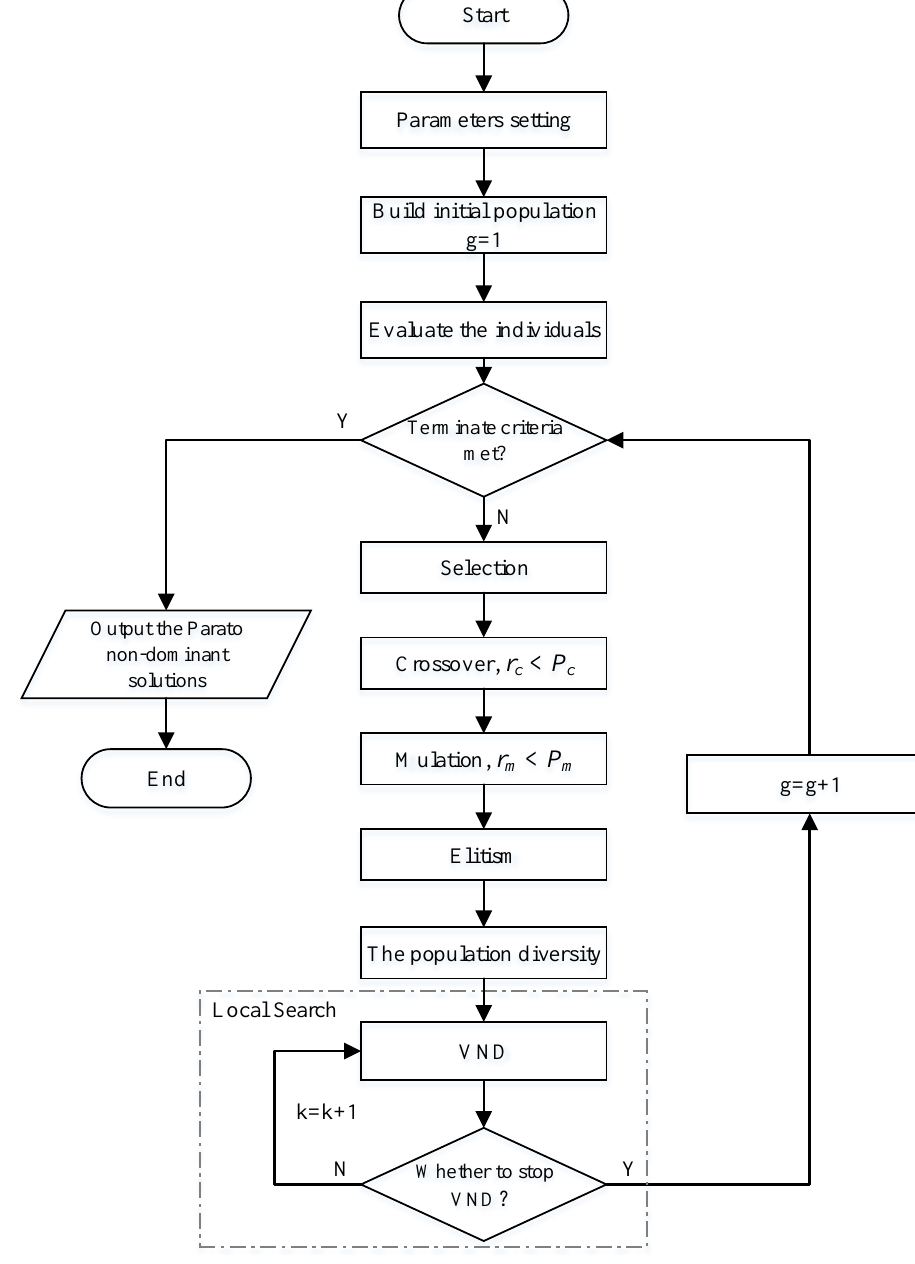
Figure 1. The flowchart of the HNSGA-II-VND.